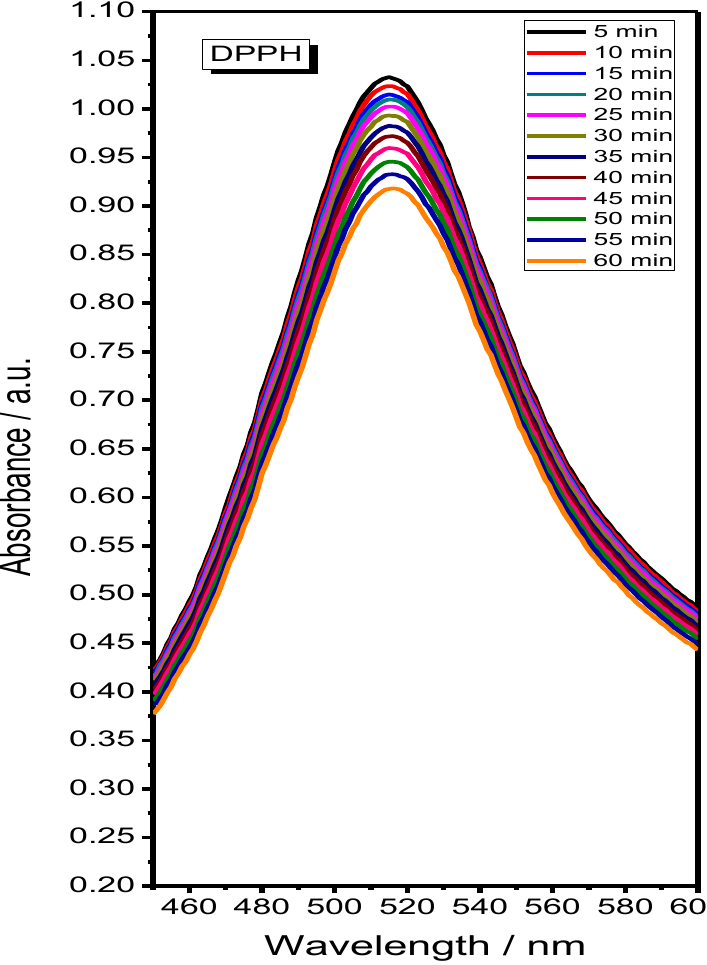
Figure 8. Time dependency of 2,2-diphenyl-1-picrylhydrazyl (DPPH•) scavenging in the absence of